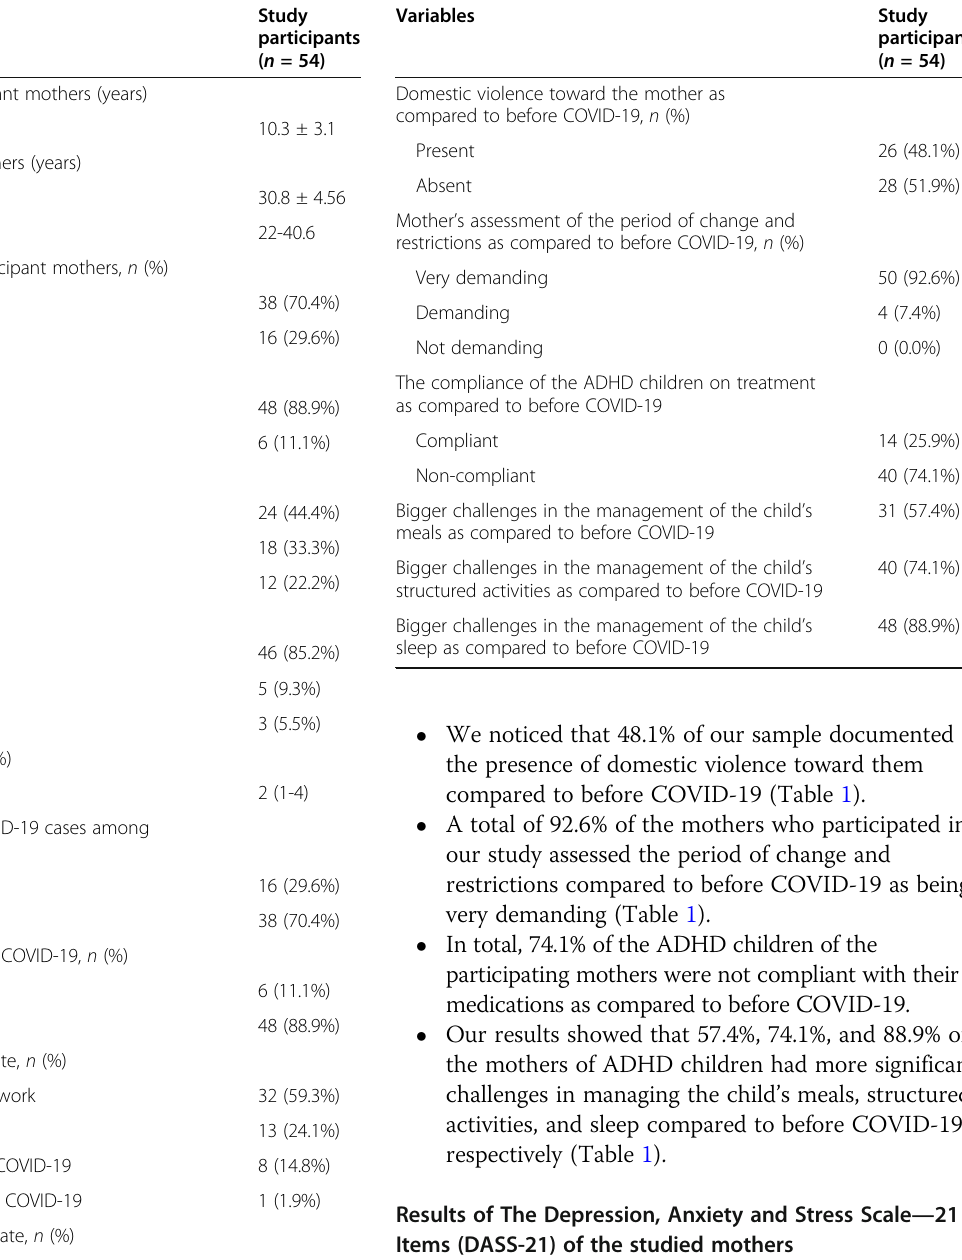
Table 1 Demographic and other characteristics of the study participants